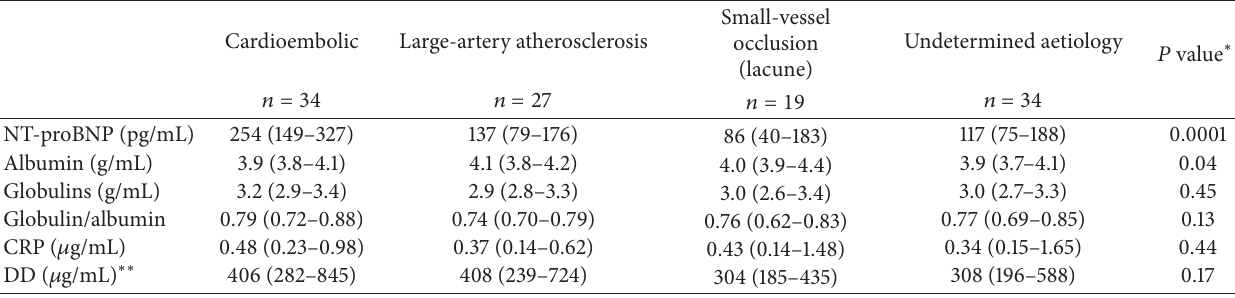
Table 2: Biomarker distribution in 114 patients according to TOAST classification.